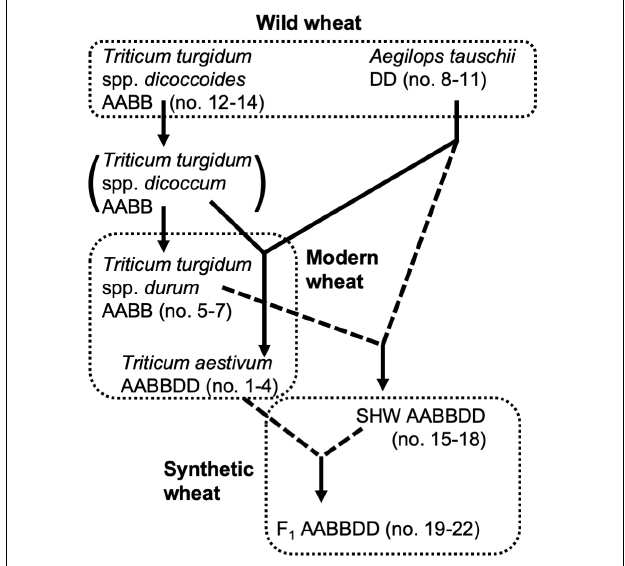
FIGURE 1 | Genetic relationship of wheat species used in this study. Dotted lines indicate hybridization and crossing performed for this